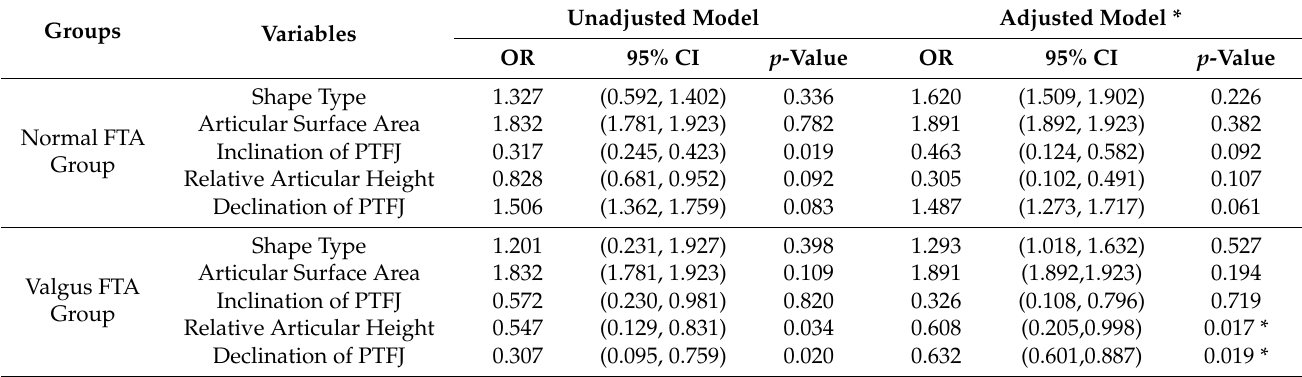
Table 3. The association between PTFJ morphological parameters and knee alignment (the varus FTA group was chosen as the control group ( n = 43)) for the valgus FTA group ( n = 10), and the normal FTA group ( n = 14).